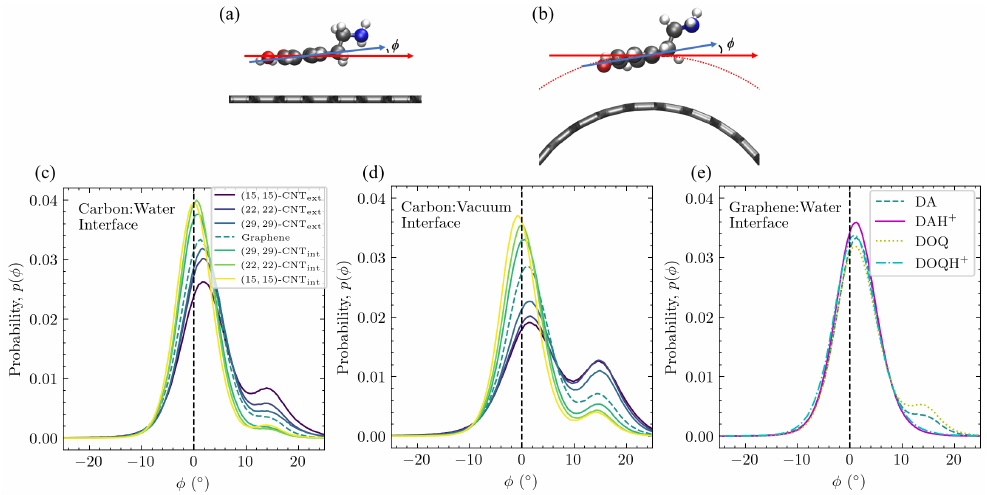
Figure 9. Tilt angle distributions of DA and other adsorbates on differently curved and solvated CNT and graphene surfaces. The tilt angle φ is defined as shown in ( a , b ) between the C2–C7 vector (blue arrows) and a vector tangent to the surface at the midpoint of the C2–C7 vector (red arrows). φ distributions for DA on differently curved surfaces, plotted as histograms with a binwidth of 0.36 ◦ , are shown in ( c ) at the carbon:water interface and in ( d ) at the carbon:vacuum interface. The results for DA, DOQ, and their protonated counterparts are shown in ( e ) on solvated flat